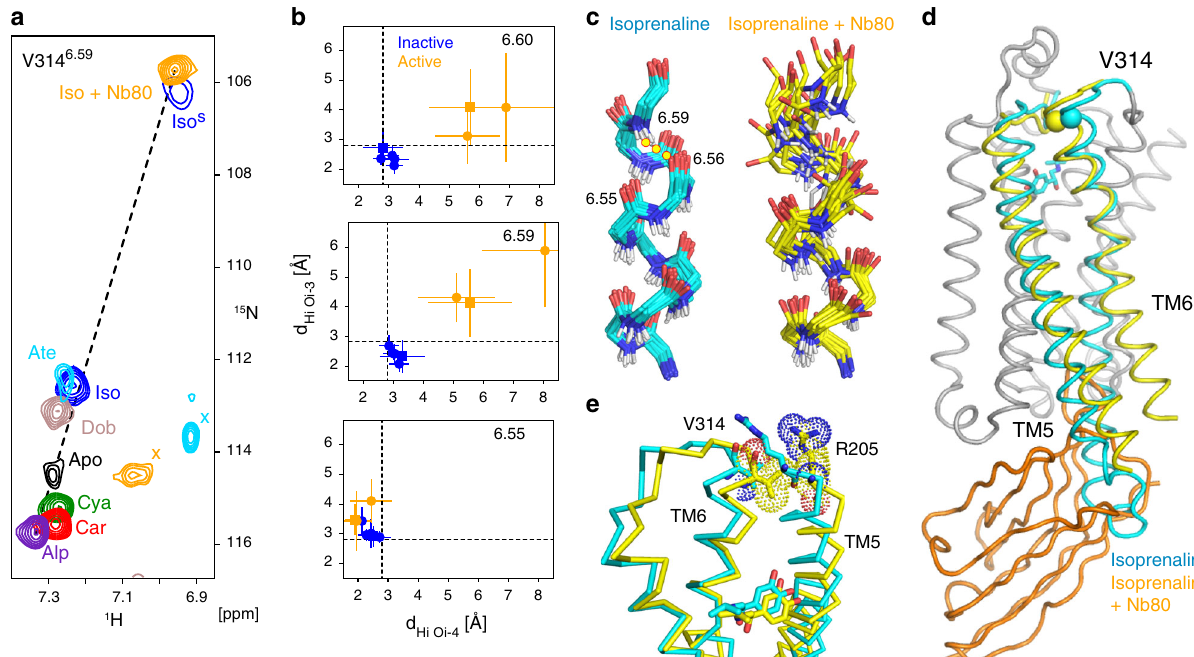
Fig. 6 Ligand-induced chemical shift changes at the extracellular end of TM6. a Selected region from 1 H- 15 N TROSYs showing the variation of the V314 6.59 1 H- 15 N resonances in the apo form and in orthosteric binary and ternary isoprenaline (cid:129) Nb80 complexes of YY- β 1 AR at 21 T and 304 K. Due to limited stability, the apo form of YY- β 1 AR was recorded at 294 K. Spectra are color-coded and marked according to the ligand. Due to exchange broadening, the resonance marked by ‘ Iso s ’ was only observed at 14 T. It corresponds to the second, minor conformation of the YY- β 1 AR (cid:129) isoprenaline complex and coincides with the resonance of V314 6.59 resonance in the ternary isoprenaline (cid:129) Nb80 complex (orange). Unrelated resonances are marked by ‘ x ’ . A dashed line visualizes the approximate linear correlation between 1 H and 15 N chemical shifts of V314 6.59 in various receptor states. b Hydrogen bond distances d HiOi-4 and d HiOi-3 for residues 6.54, 6.59 and 6.60 in β 2 AR (square) and β 1 AR (circle) from Phenix ensemble calculations for binary orthosteric ligand complexes (2Y03, 2RH1, 2VT4 chain A and B; blue) and ternary agonist complexes (4LDL, 6H7J; orange). Source data are provided as a Source Data fi le. c Ensemble backbone structures ranging from residue 6.50 – 6.59 derived by the Phenix ensemble calculations for β 1 AR (cid:129) isoprenaline (2Y03, cyan) and β 1 AR (cid:129) isoprenaline (cid:129) Nb80 (6H7J, yellow). The 3 10 hydrogen bond H 6.59 (cid:129)(cid:129)(cid:129) O 6.56 in the agonist-bound structure is shown as a dotted line. d Evidence for the TM6 pivoting in response to nanobody binding in the crystal structures of β 1 AR. Structures of the binary complex with the agonist isoprenaline (2Y03) and of the ternary complex with agonist isoprenaline and Nb80 (6H7J) were aligned on the central region of the unaffected helices TM1-4,7 (shown in gray for 2Y03). TM5 and TM6 are depicted in cyan for the binary complex and in yellow for the ternary complex. The V314 N atoms are depicted as spheres, nanobody Nb80 as an orange ribbon. e Ligand-binding pocket of the binary and ternary complex β 1 AR structures as shown in d . Residues V314 6.59 , R205 5.37 and ligands are depicted in stick representation. Van der Waals spheres are shown for V314 6.59 and R205 5.37 in the ternary complex to visualize their